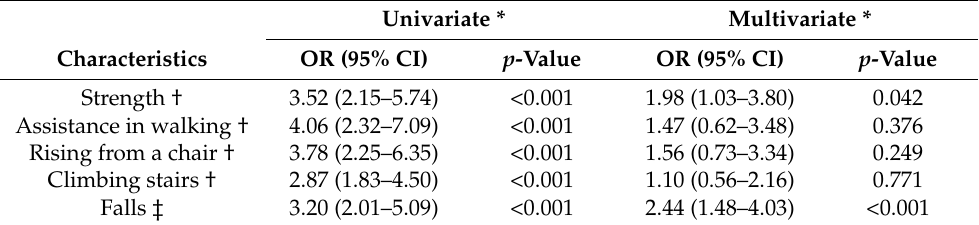
Table 2. The relationship between the SARC-F items and sarcopenia.